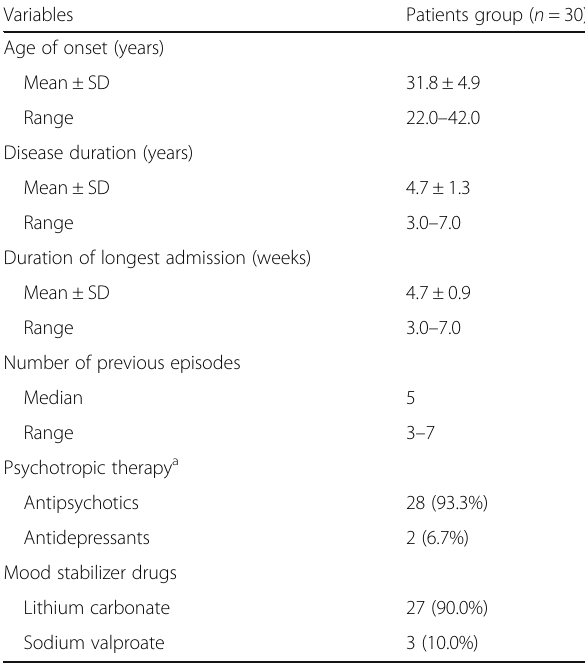
Table 2 Clinical characteristics of the studied patients Variables Patients group ( n = 30)